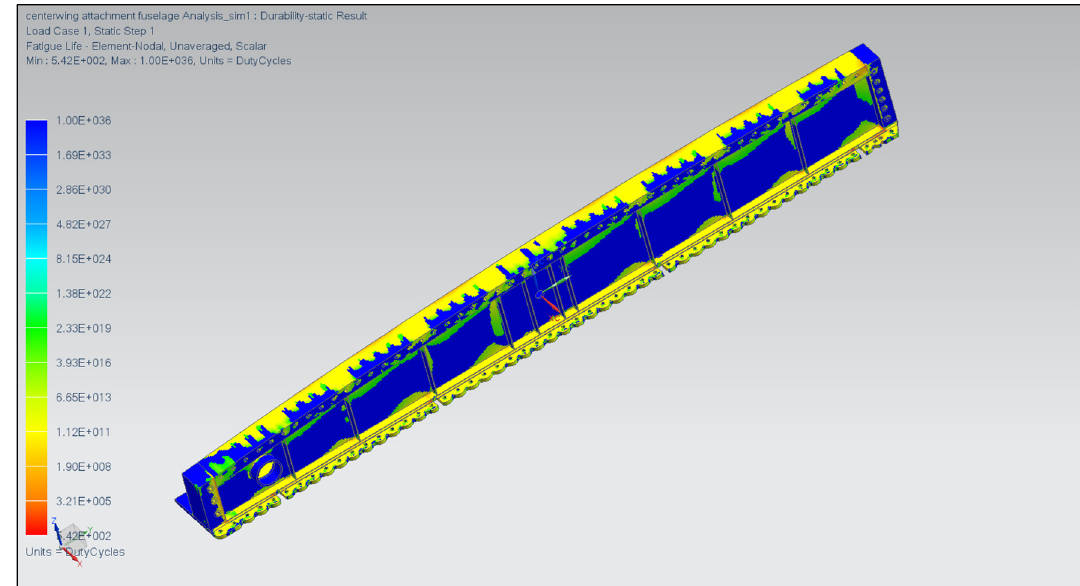
Figure 21. FEA of wing root joint.